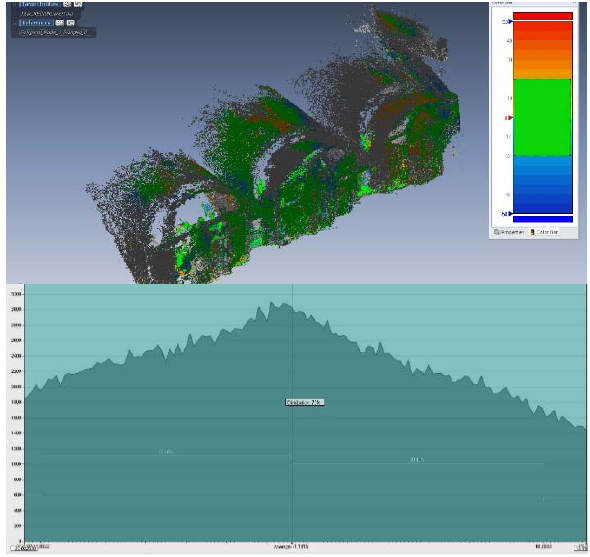
Figure 10. Graphic and numerical deviation between scans.